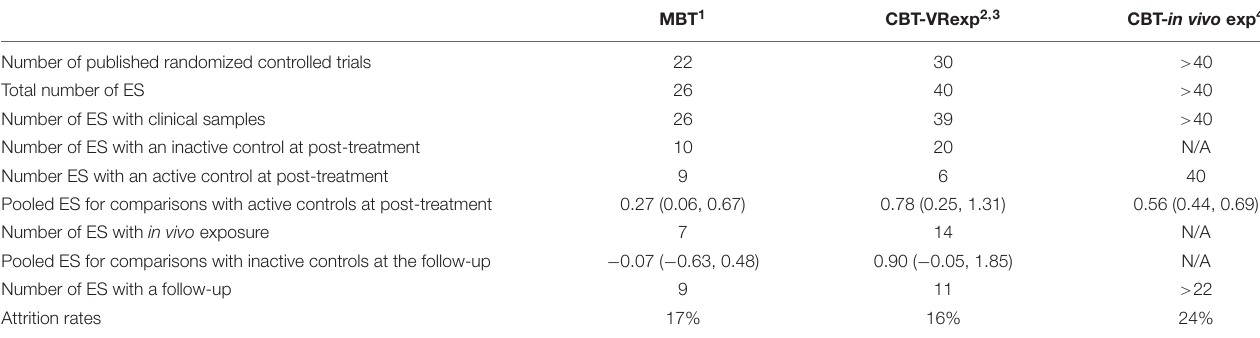
TABLE 1 | Documenting the relative weight of evidences, based on the number of clinical trials on MBT and CBT-VRexp and on in vivo exposure as a reference, and the pooled effect